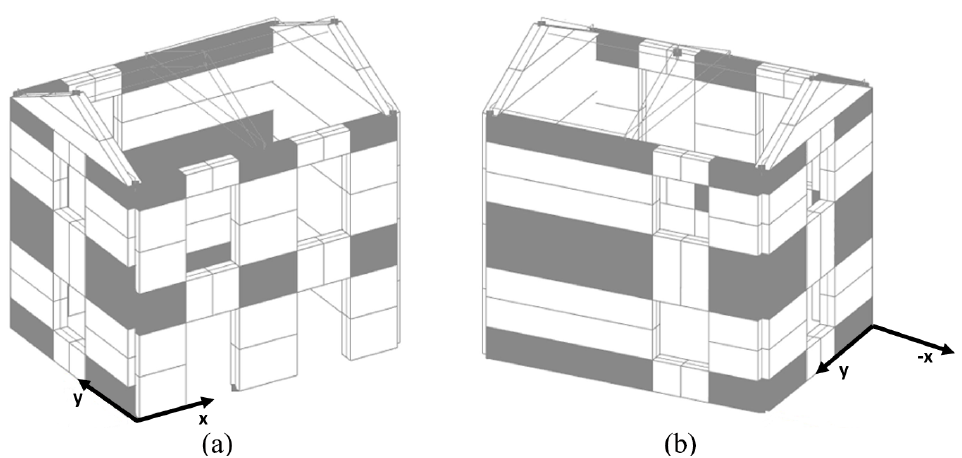
Figure 7. OpenSEES model of Pavia Building 1: ( a ) View from the northwest corner. ( b ) View from the northeast corner. Table 2. Pavia Building 1: Material parameters of diaphragms and the wall-to-diaphragm connections.